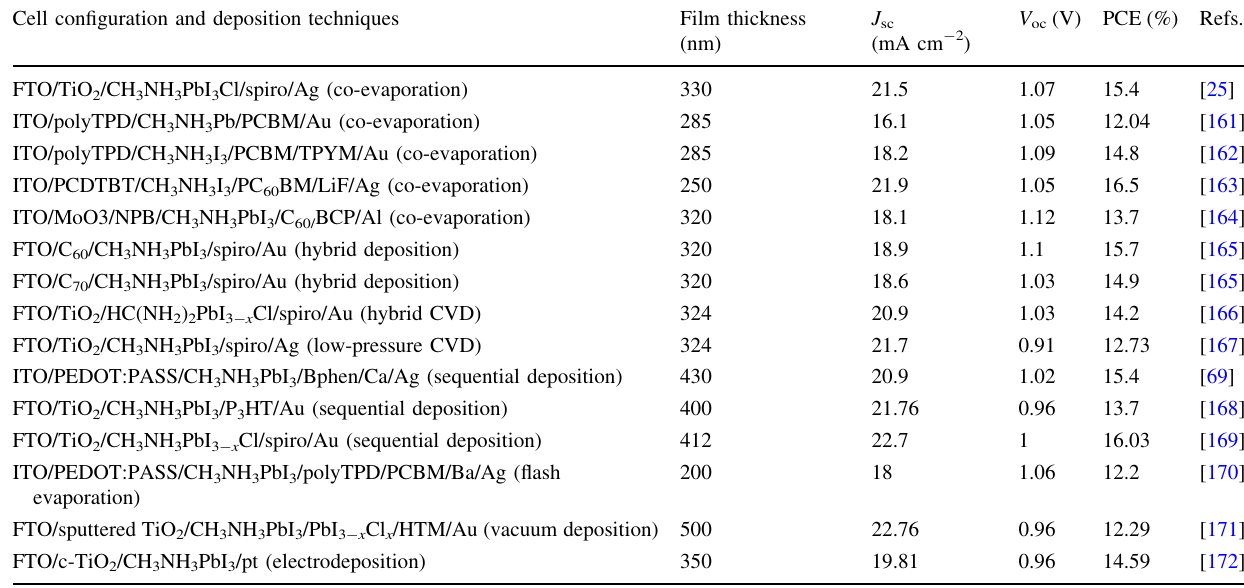
Table 6 Summary of perovskite solar films fabricated by the different vapor-based techniques and corresponding PCE Cell configuration and deposition techniques Film thickness